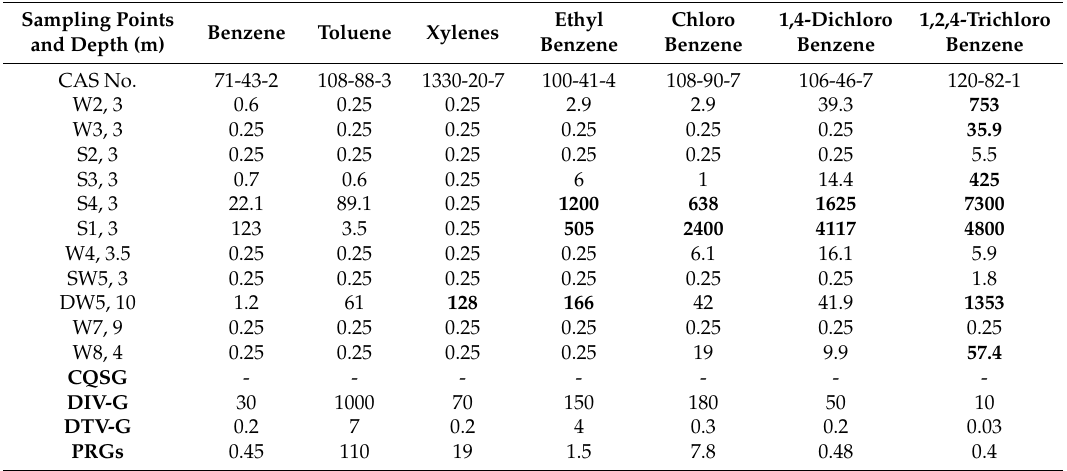
Table 2. Contaminants found in groundwater samples at the Luhe site (Unit: µ g/L). Sampling Points and Depth